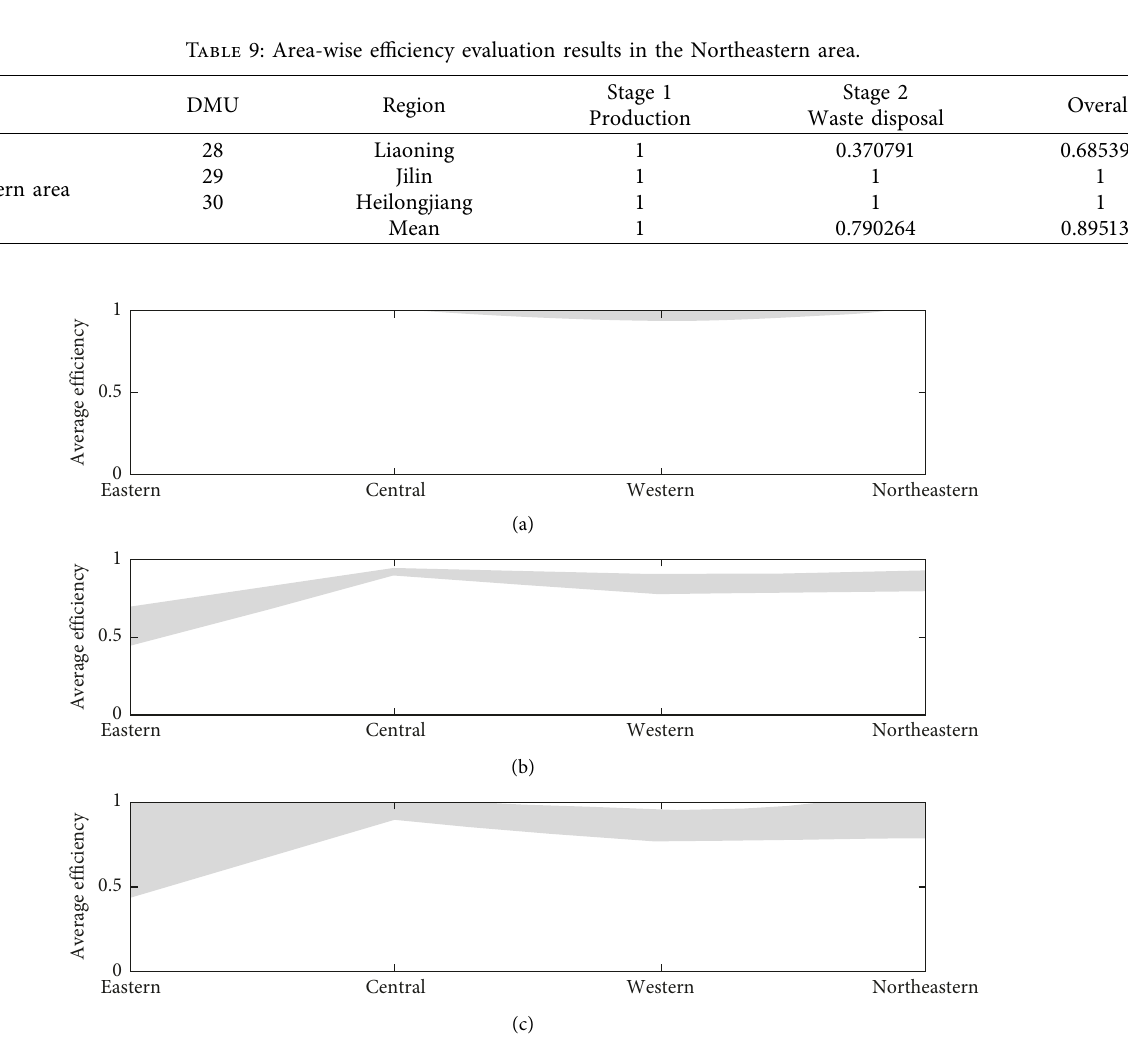
Figure 5: Sensitivity analysis of parameter w in the area-wise efficiency evaluations. (a) Average efficiency scores in stage 1. (b) Average efficiency scores in stage 2. (c) Average overall efficiency